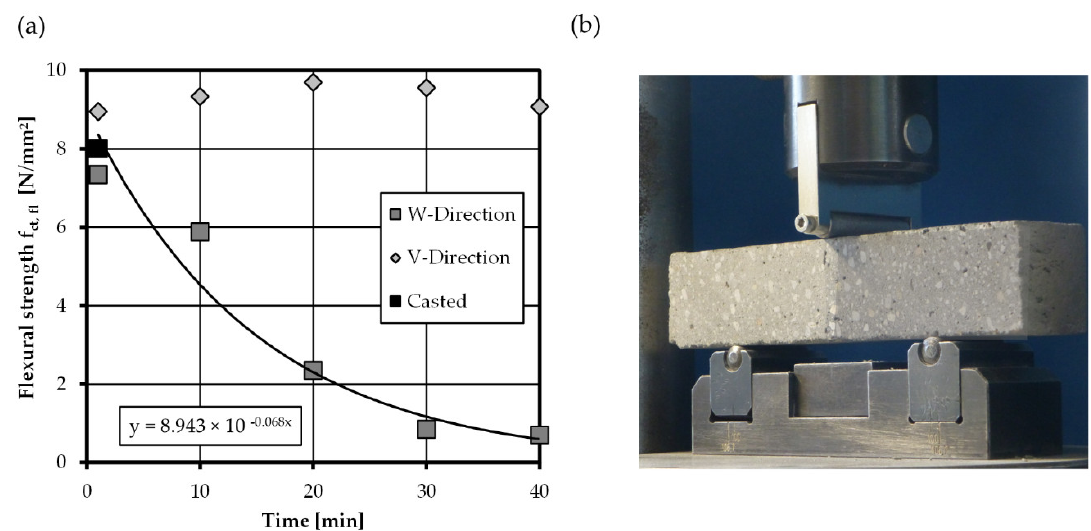
Figure 8. ( a ) Development of average flexural strength in W- and V-Direction with increasing interval time, note that the flexural strength of casted specimens is 8 N/mm 2 , ( b ) test setup flexural bending tests according to [37] (note the different concrete colors, marking the tested interface).